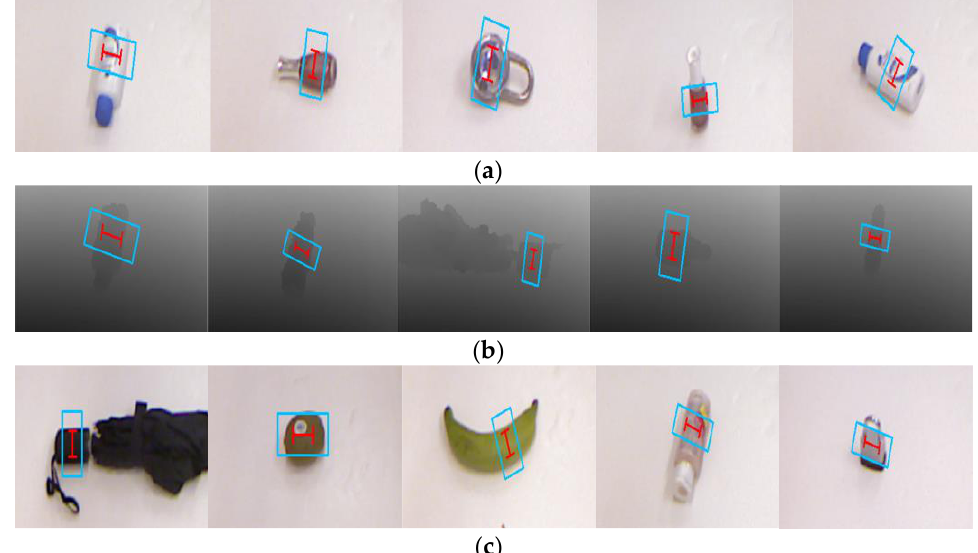
Figure 5. Grasping detection results on the Cornell dataset: ( a ) the evaluation results using RGB images, ( b ) the results using depth images, ( c ) the results using RGB-D image. The blue rectangle refers to the opening width when the gripper approaches the object, and the red “I” represents the closing width when the gripper picks up the object.